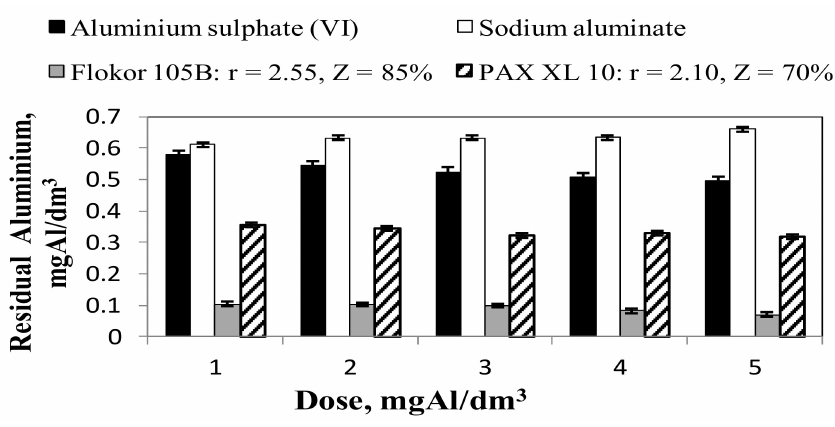
Figure 3. E ff ect of the type and dose of coagulants on the concentration of aluminium residual in the treated